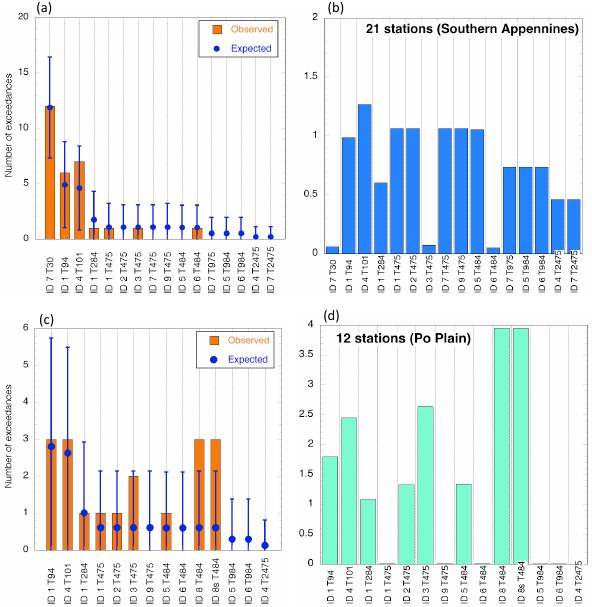
Figure 9. Results of scoring for sub-regions in Italy, as in Fig. 7: (a) , (b) southern Apennines; (c) , (d) Po